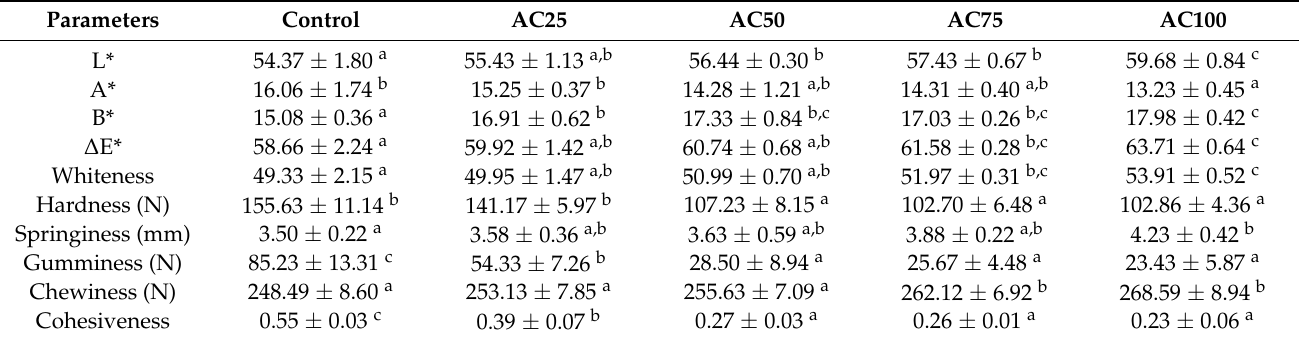
Table 3. Color and textural profile of sausages with substitution of pork fat by Auricularia cornea (AC). Parameters